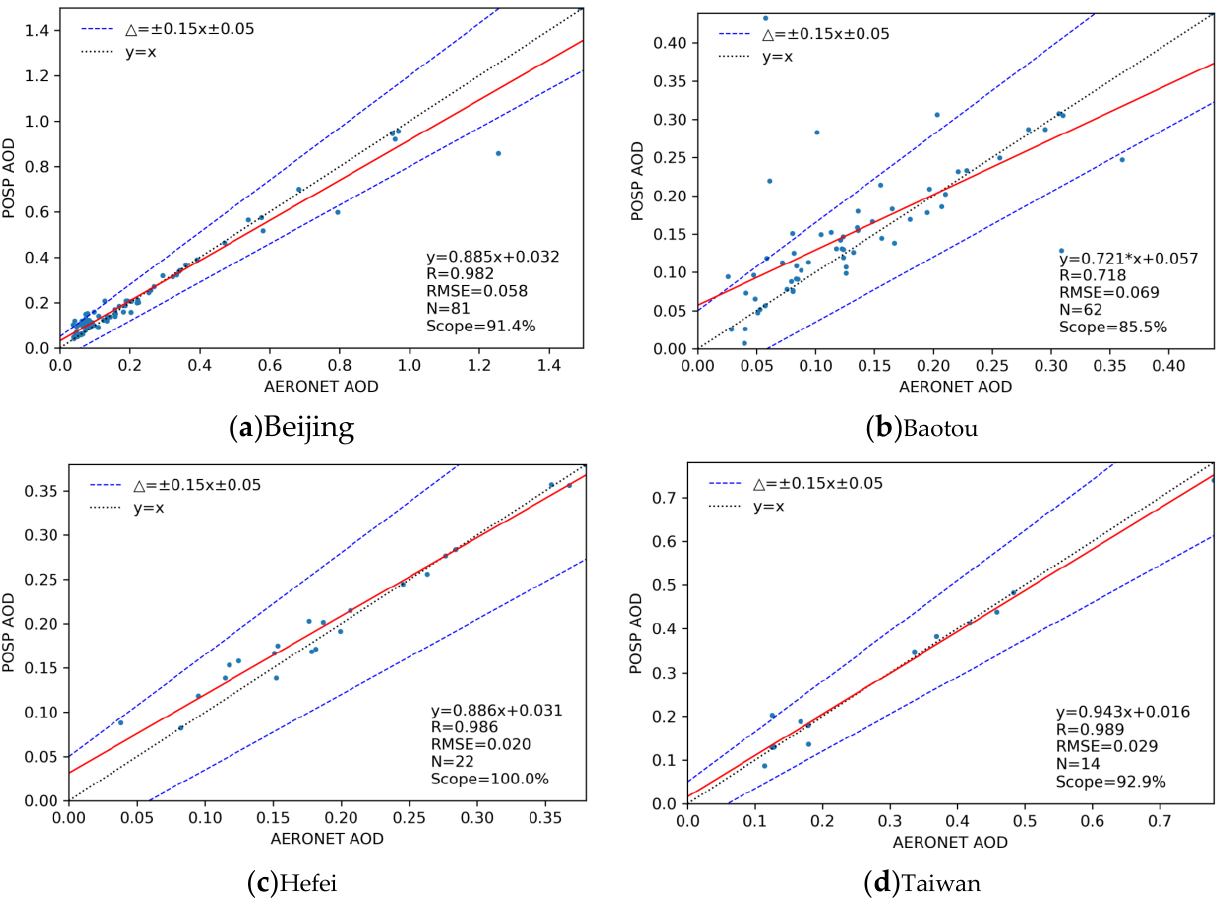
Figure 5. Validation of the AOD at 670 nm with the proposed method against AOD at 675 nm in AERONET products at Beijing, Baotou, Hefei and Taiwan sites.